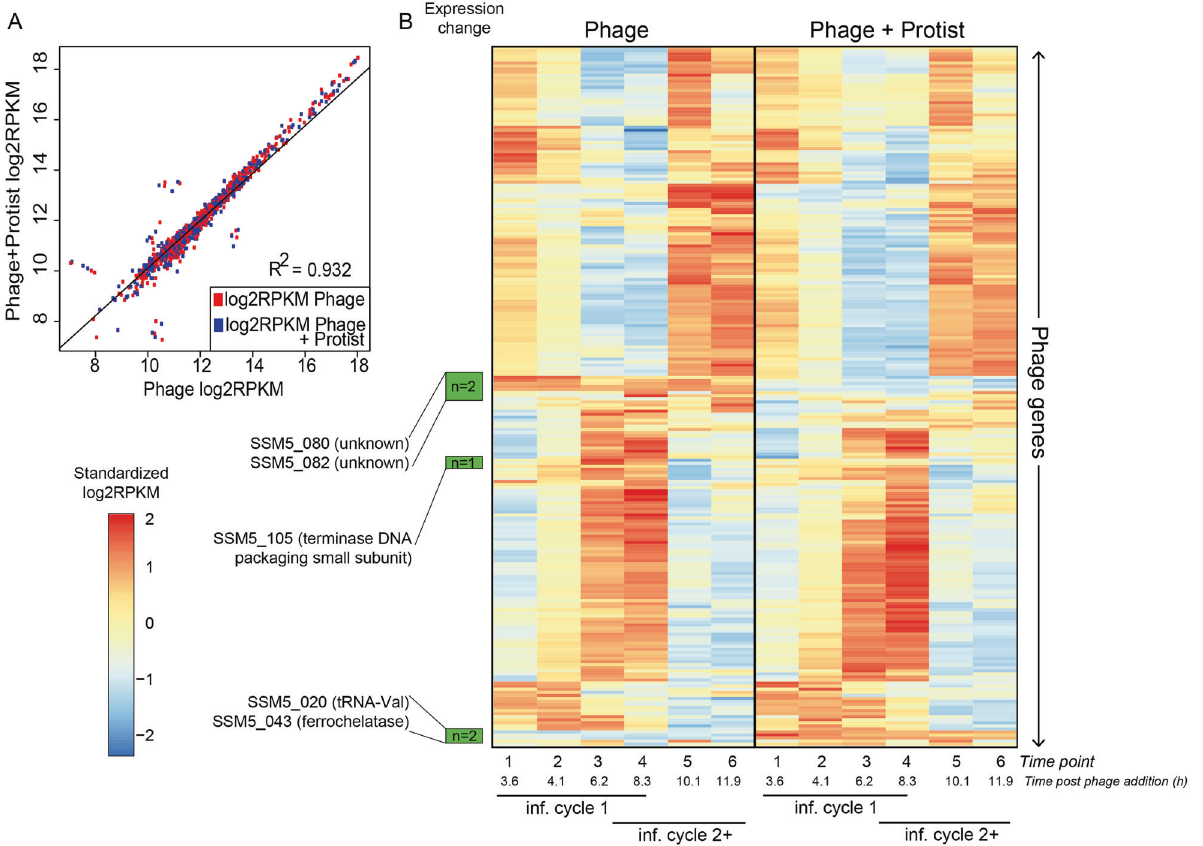
Fig. 2 Phage expression in the presence and absence of the protist. A Pearson correlation of the phage gene expression values (as log 2 RPKM) with and without protist shows that phage expression levels are largely the same in both treatments. B Heatmap representing the expression (as standardized log 2 RPKM) of all phage genes (vertical) in the treatment with (right) or without (left) protists. Genes that change temporal dynamics in the presence of protists are marked in green (5 in total) and their annotations are displayed. The known transcriptional categories for this and generally the T4-like myophages (early, middle and late-expressed genes) are unaltered with protist for all except 5 genes (see Supplementary text). The time course for the infection captures more than one infection cycle: the fi rst one with the phages added at the start of the experiment ( “ inf. cycle 1 ” ) and the ones that follow once the phages are released from “ inf. cycle 1 ” and infect new cells ( “ inf. cycle 2 + ”